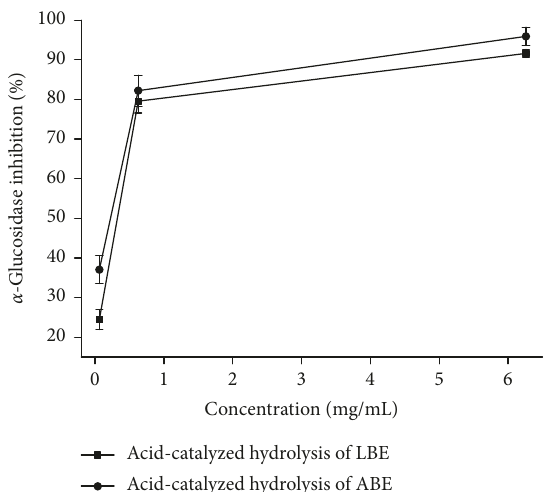
Figure 8: Dose-response curves for α -glucosidase inhibitory ac- tivity at different concentrations of acid-catalyzed hydrolysis of proanthocyanins from ABE and LBE. Data are expressed as mean one standard deviation. ±